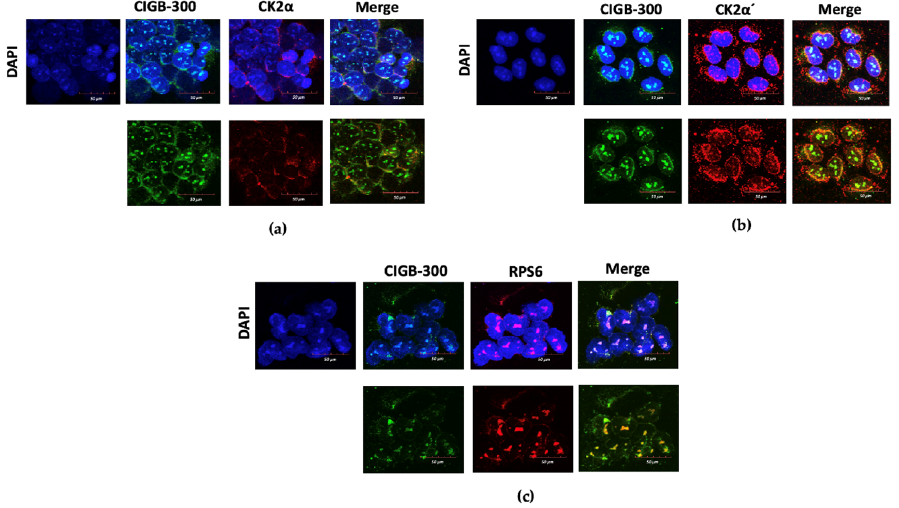
Figure 6. Confocal microscopy in NCI-H460 cells: ( a ) Interaction panel of CIGB-300 and CK2 α ; ( b ) Interaction panel of CIGB-300 and CK2 α′ ; ( c ) Interaction panel of CIGB-300 and RPS6. Blue fluorescence: nuclear DAPI stain. Green fluorescence: CIGB-300-B was incubated at IC 50 value during 0.5 h and identified with Streptavidin-FITC. Red fluorescence: Corresponding proteins were identified with a primary antibody and then with a secondary antibody conjugated to AlexaFluor 500. Orange fluorescence: Merge of Green/Red channels representing colocalization signals. Scale bars: 50 µm.